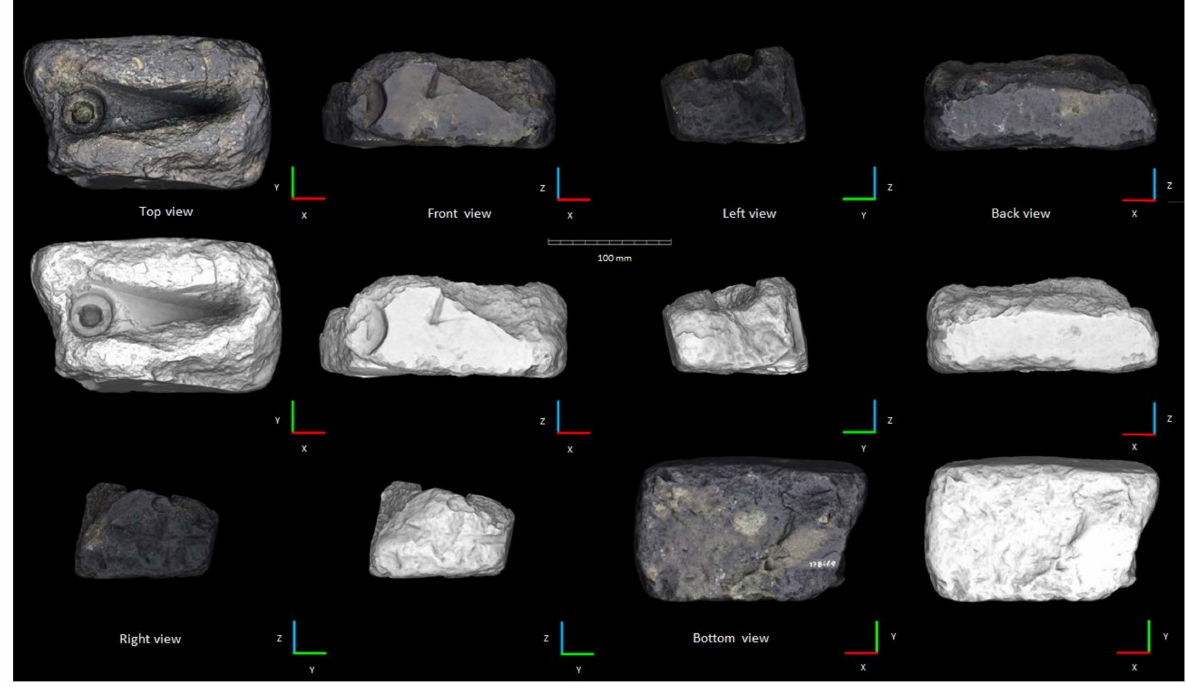
Figure 14. Orthoviews from N1 3D model, with texture and Shade Vis Plug-in; visualization with CloudCompare software.